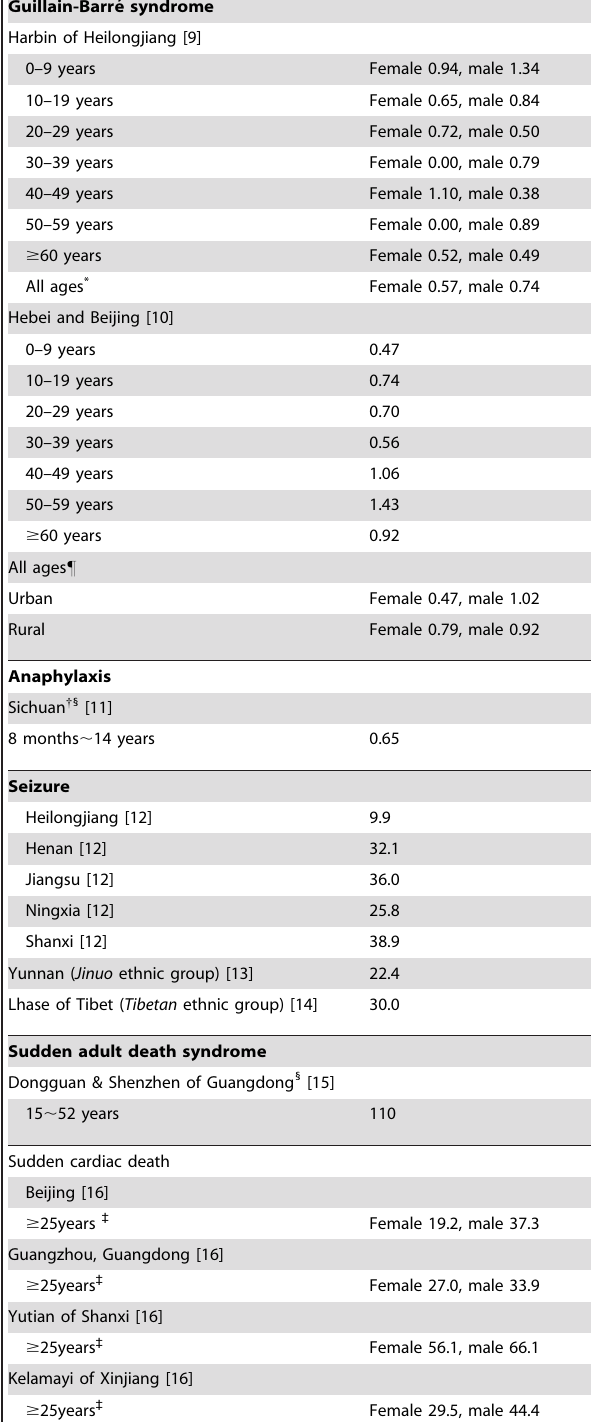
Table 1. Incidence of disease events that might be temporarily associated with vaccine by genders, provinces and age groups.